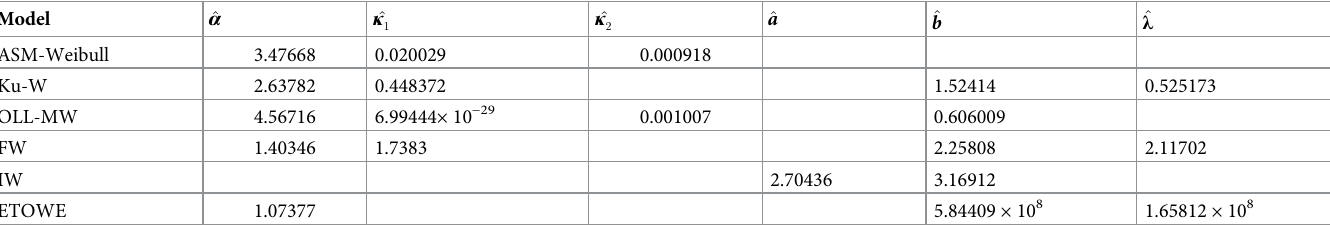
Table 9. Corresponding to the second COVID-19 data, the estimated values of the parameters of the fitted distributions. Model